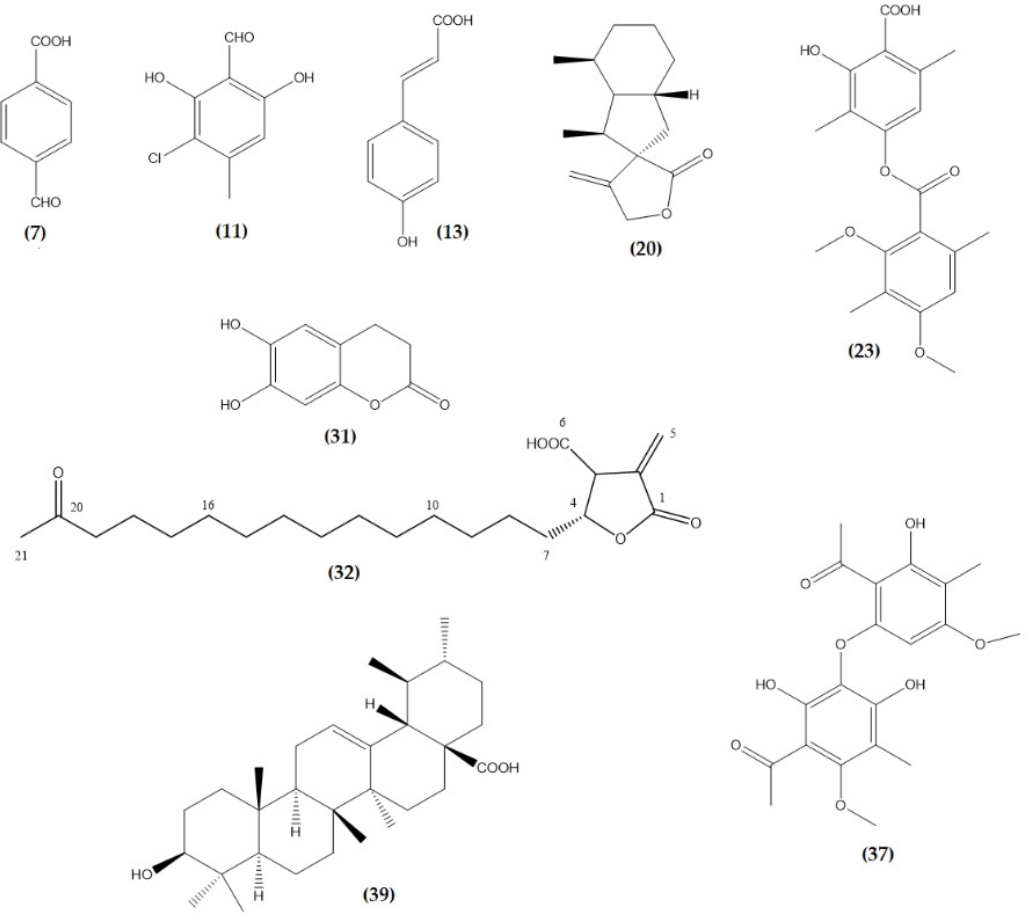
Figure 5. Chemical structure of compound 7 , 11 , 13 , 20 , 23 , 31 , 32 , 37 , and 39 identified in ME-hex of Physcia mediterranea by UHPLC/ESI/MS/MS.